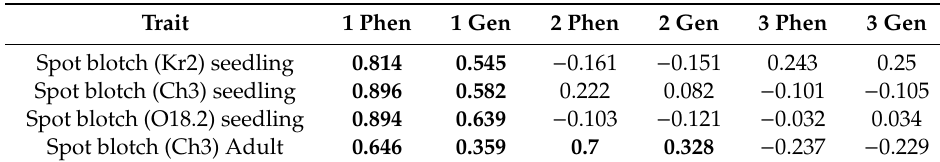
Table 2. Correlation coe ffi cients of investigated traits with all bi-components. Strong correlation is in bold.